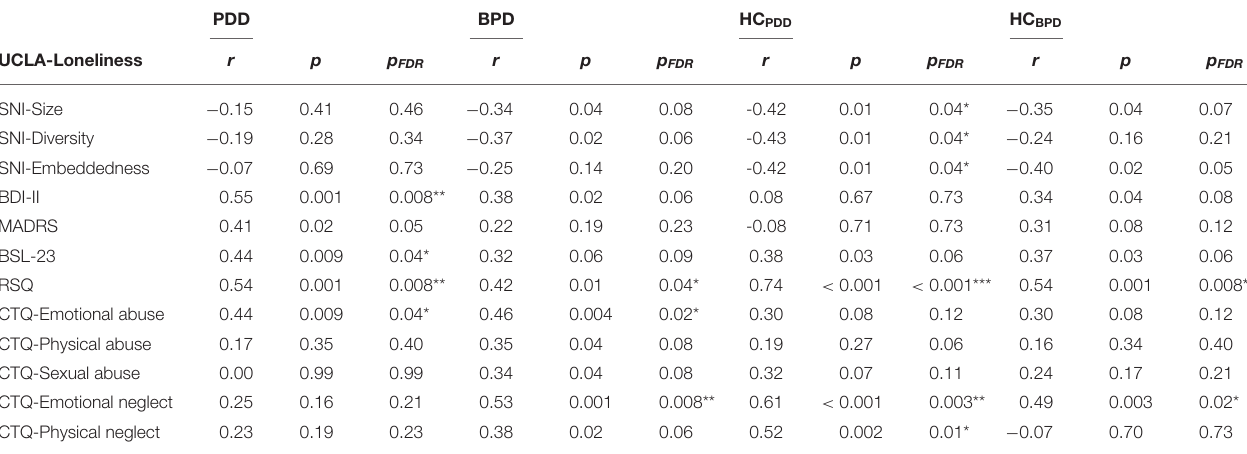
TABLE 3 | Correlation coefficients of loneliness with social network characteristics, clinical symptoms, and childhood maltreatment. PDD BPD HC PDD HC BPD